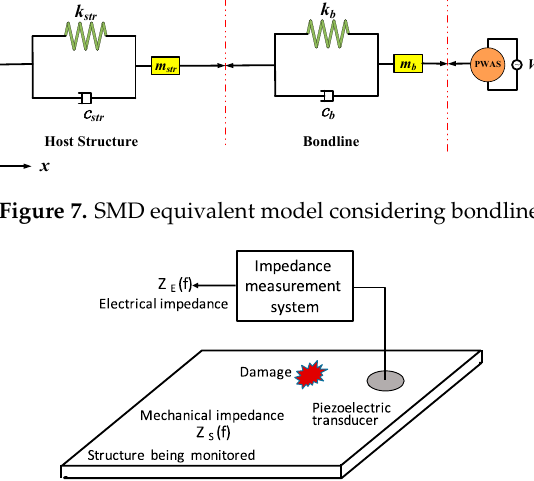
Figure 7. SMD equivalent model considering bondline.